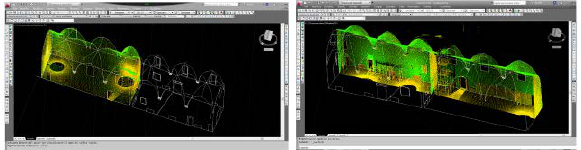
Figure 11. 3D models: three-dimensional wireframe model obtained by modelling on the point cloud in the CAD environment (software: Cloudworks, Autocad).